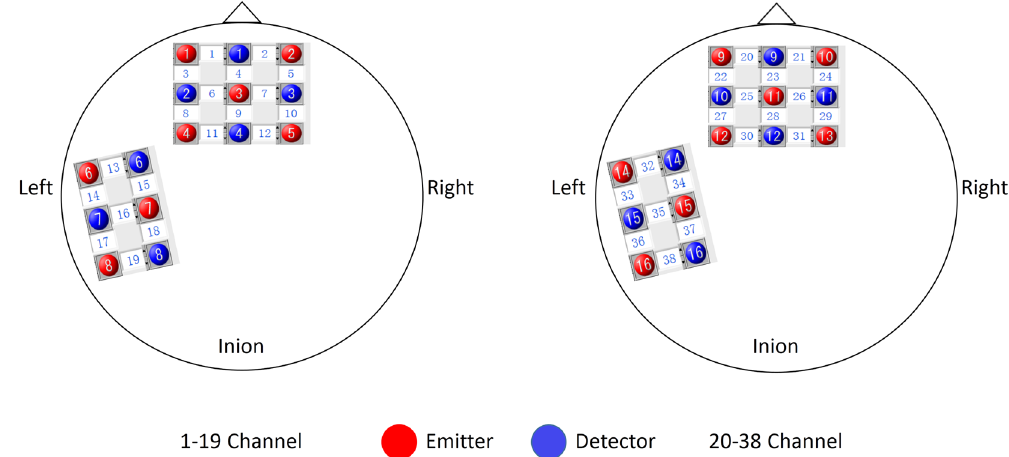
Figure 7. Positions of fNIRS channels. Nine optodes (five emitters and four detectors) were attached to the forehead in a 3 × 3 lattice pattern forming 12 measurement channels. The distance between adjacent emitters and detectors was 3 cm, and the central area between a paired emitter and detector was defined as a measurement channel. The leftmost channel in the lowest line was located at the center position of Fp1 and Fp2 of the international 10–20 system. Accordingly, the frontal panel covered approximately the medial prefrontal cortex (mPFC) and the dorsal lateral prefrontal cortex (dlPFC). The remaining six optodes (three emitters and three detectors) were placed on the left temporal lobe in a 2 × 3 lattice pattern forming 7 measurement channels. The middle channel in the lowest line was located at the T3 position of the international 10–20 system, and thus the left panel covered approximately the posterior superior temporal sulcus